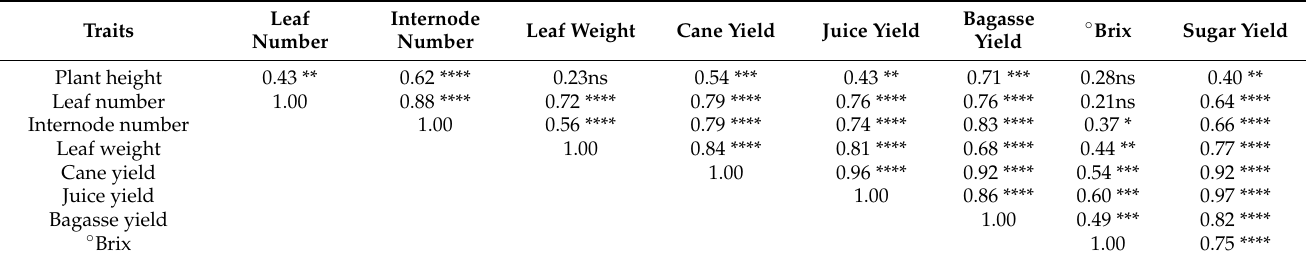
Table 3. Phenotypic correlation coefficient of different agro-morphological traits obtained from 14 sorghum genotypes. Traits Plant height